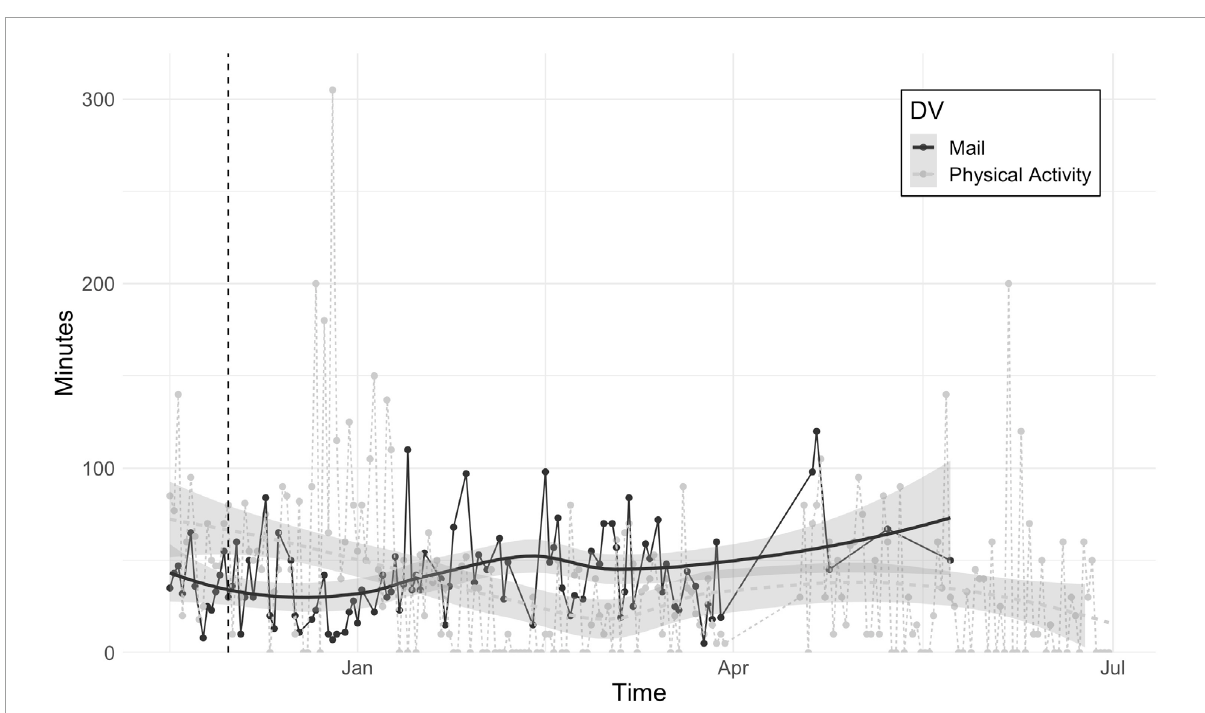
FIGURE6 Minutes spent using mail app and engaging in physical activity over the course of treatment. The dashed vertical line indicates the start of treatment. Shaded area shows 95% confidence intervals for best-fitting